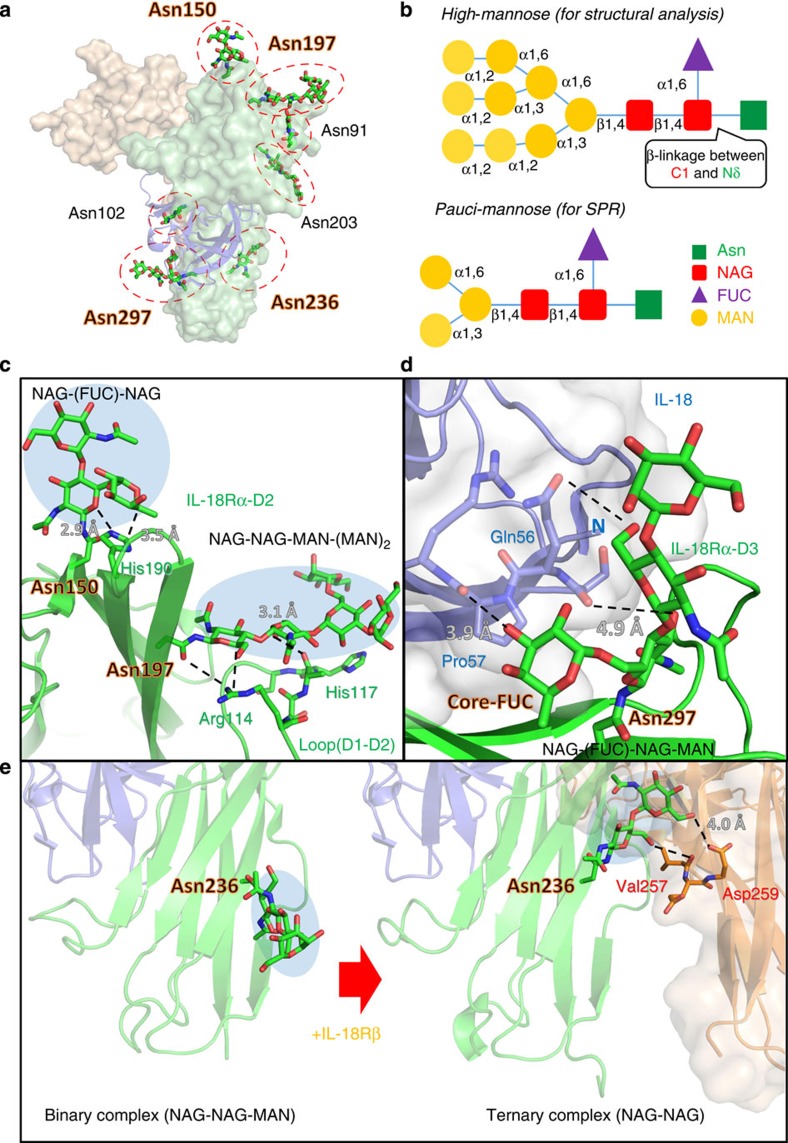
The sugar contacts that maintain IL-18/IL-18Rα/IL-18Rβ.(a) The N-linked glycans identified from the structure. (b) The N-linked glycosylation in this study. (c) Intramolecular interactions between the carbohydrates on Asn150Rα and His190Rα as well as on Asn197Rα and the D1-D2 loop. (d) Interactions between the N-linked carbohydrates on Asn297Rα and IL-18. Core-FUC moderately interacts with IL-18 at an ~4 Å distance. (e) Interactions between the N-linked carbohydrates on Asn236Rα and IL-18Rβ.